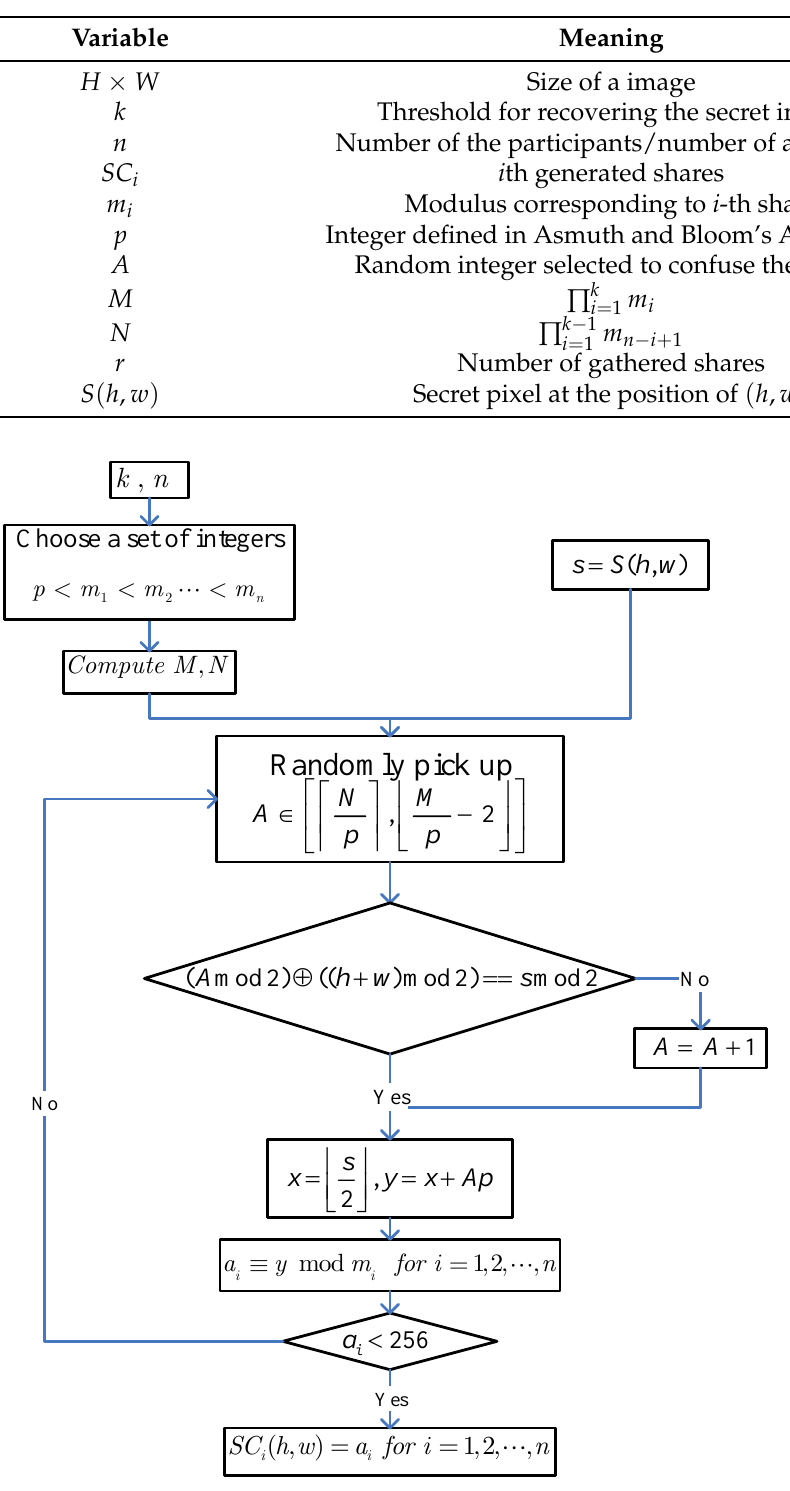
Table 1. Variables used in Algorithms 2 and 3.